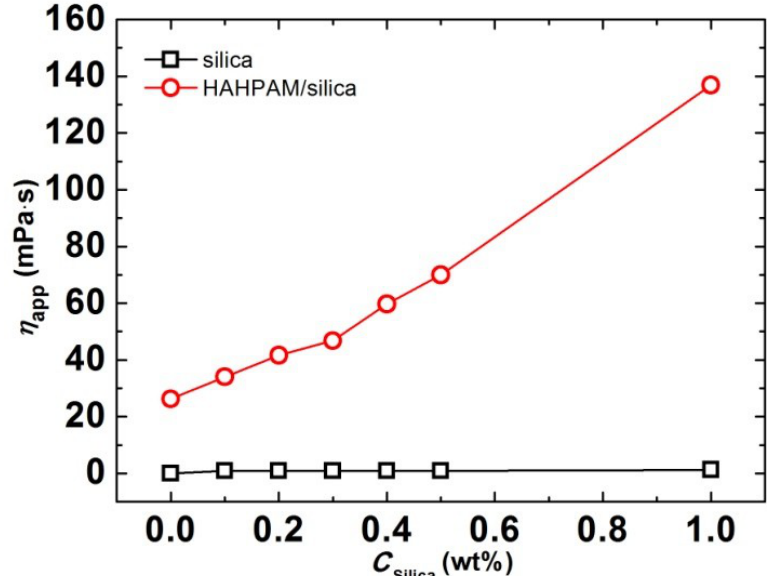
Figure 2. Dependence of apparent viscosity on silica nanoparticle concentration for HAHPAM/silica hybrids in brine and silica suspension (TDS = 32,868 mg∙L −1